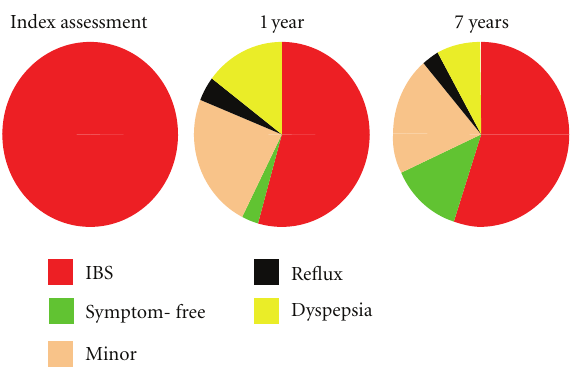
Figure 1: Representative diagram of the stability over time of IBS: percentage of the patients reporting IBS after 1 and 7 years from the first interview. Modified from [1].